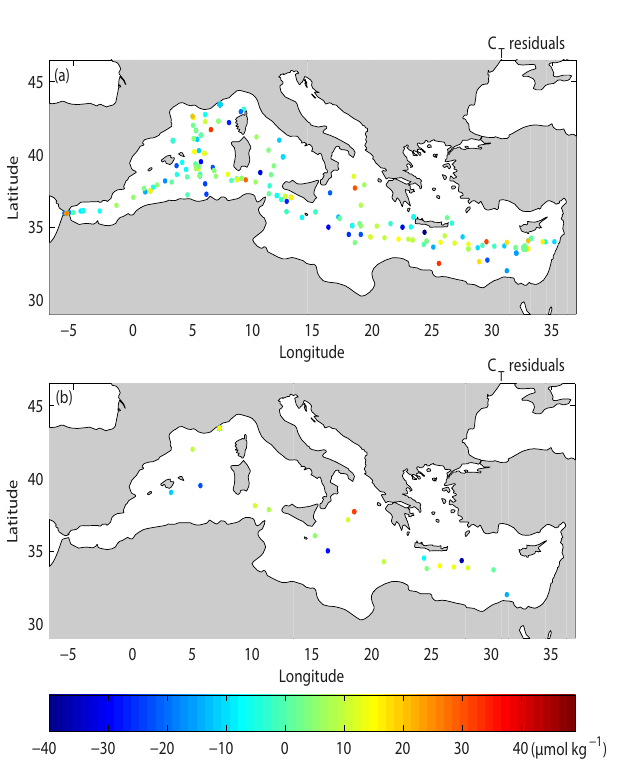
Figure 5. Comparison of the predicted C T values from the C T al- gorithm given in Eq. (2) with measurements which are (a) included or (b) excluded when deriving the